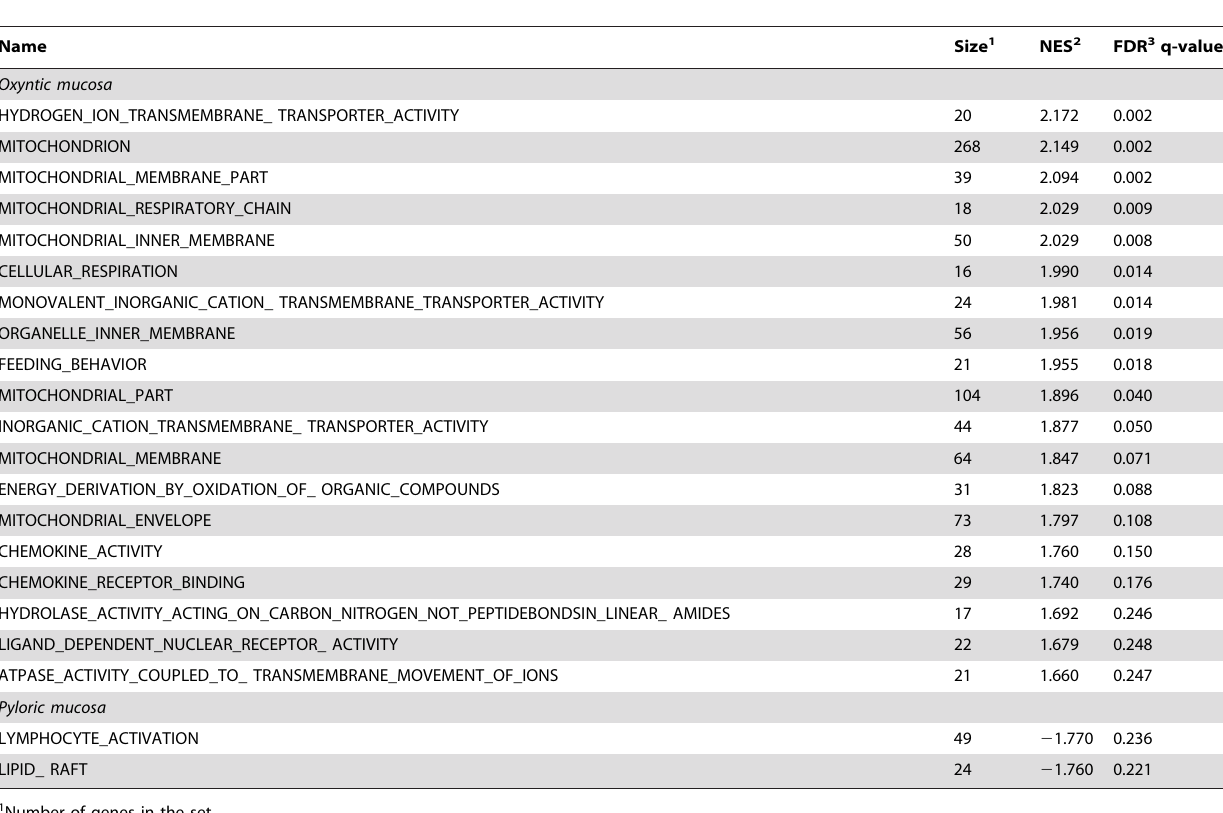
mucosa (Table 5): ATPase, class V, type 10D– ATP10D ; carbonic anhydrase 2 & 11; gastrokine 1; protein disulfide isomerase (PDI) family A, 3 & 4; Mucin 1; glutathione peroxidase 1; glutathione S- transferase alpha 4; fatty acid binding protein 5; sodium iodide symporter, member 5; pancreatic amylase. Table 2. Gene sets enriched in oxyntic and pyloric mucosae of young